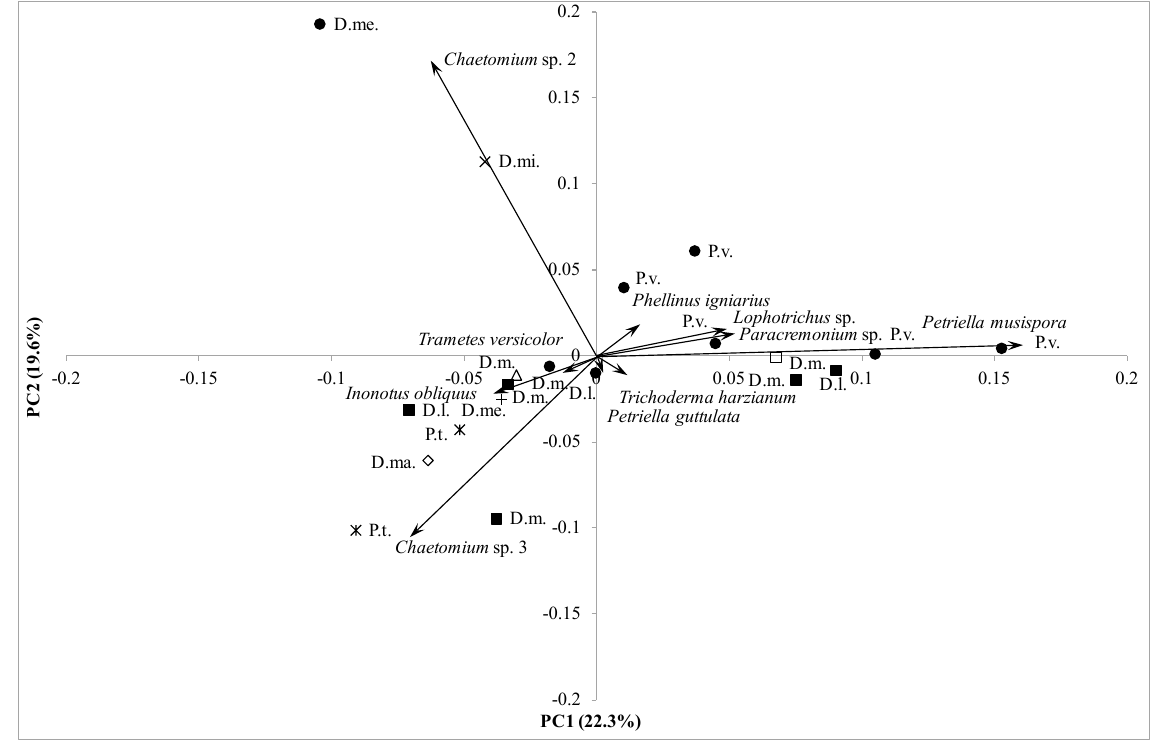
Fig. 3 Biplot of the principal components analysis (PCA) with log-transformed frequencies of fungal species, woodpecker species (D.l. – Dendrocopos leucotos ; D.m. – Dendrocopos major ; D.ma. – Dryocopus martius ; D.me. – Dendrocopos medius ; D.mi. – Dendrocopos minor ; P.t. – Picoides tridactylus ; P.v. – Picus viridis ) and cavity trees (diamond – Abies alba ; triangle – Acer pseudoplatanus ; square – Alnus incana ; fill square – Fagus sylvatica ; plus – Malus domestica ; star – Picea abies ; x – Prunus domestica ; dot – Salix fragilis ). Principal components were calculated from a covariance matrix for those fungal species for which the total sample size exceeded 20